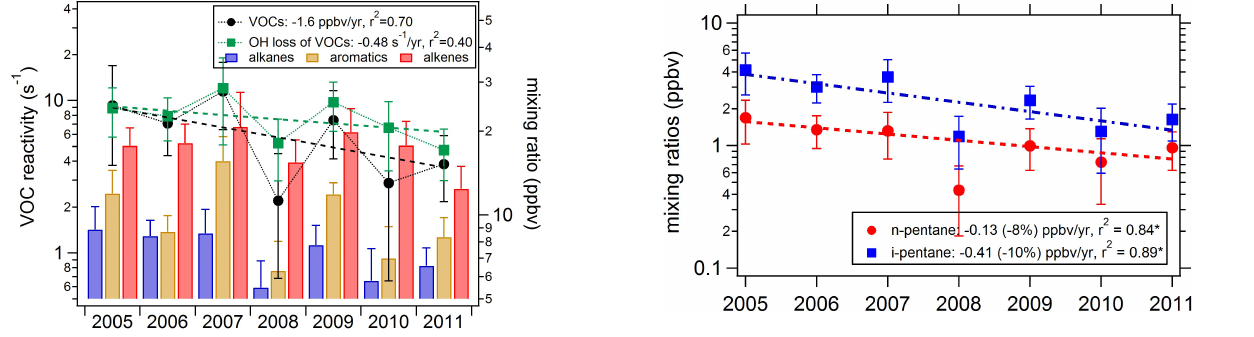
Figure 7. Variations in the daytime VOC averages (black dots) and the corresponding OH loss rates (green squares) in Beijing, Au- gust between 2005 and 2011, showing the calculated contribution to OH loss rates from alkanes (blue bars), aromatics (brown bars), and alkenes (red bars).